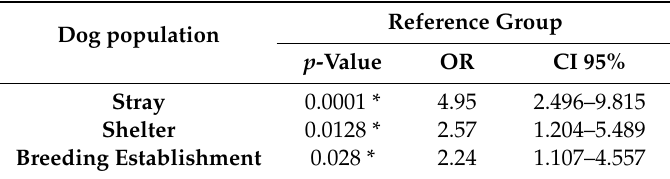
Table 2. Statistical analysis of association as per type of dog population (stray, shelter and breeding establishment; domestic dogs were considered as the reference